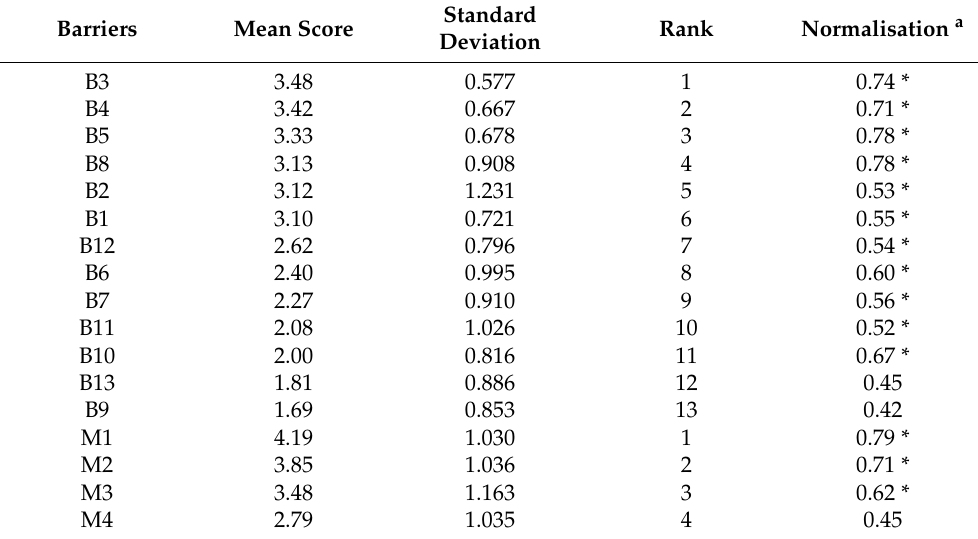
Table 5. Ranking of barriers and opportunities to base isolation’s